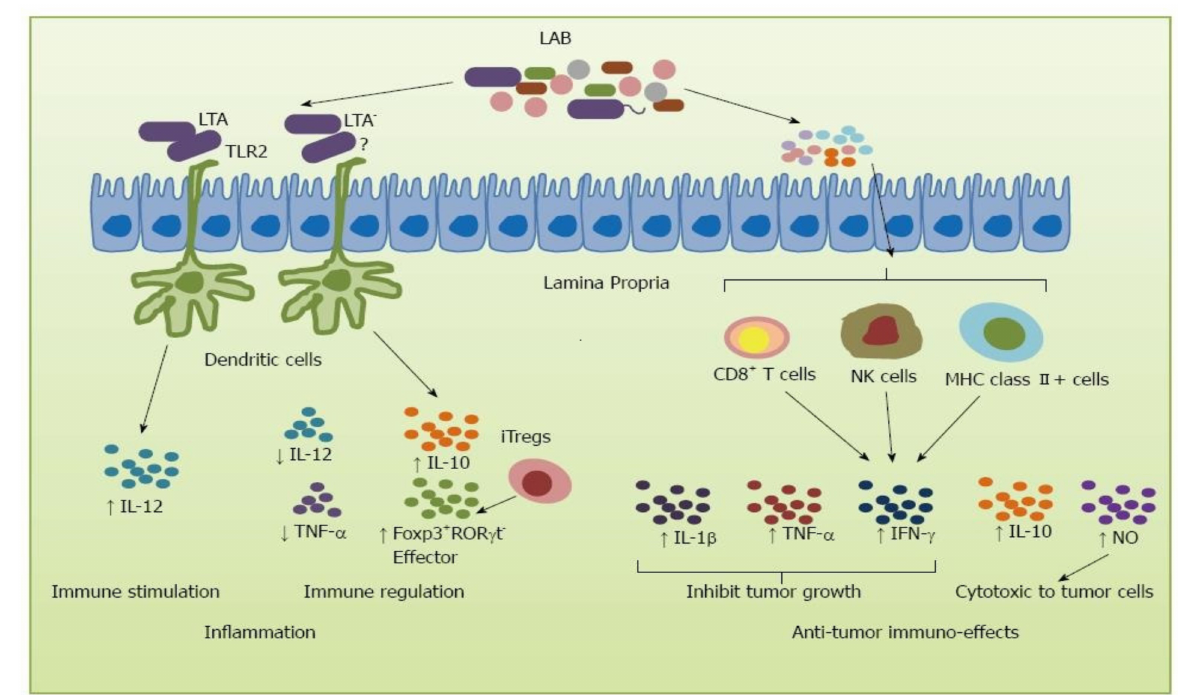
Figure 1. Immune responses induced by lactic acid bacteria. LAB can stimulate immune responses via two major pathways: inflammation and anticancer immune responses. The inflammation pathways include lipoteichoic acid (LTA) which stimulates T cells to release interleukin (IL)-10 and IL-12 and increase effectors Foxp3 + ROR γ t -Tregs. In the anticancer immune responses pathway, LAB stimulate the immune cells, such as T cells, dendritic cells (DC), natural killer (NK), and MHC class II cells to induce IL-10, and tumor necrosis factor (TNF)- α , interferon (IFN)- γ , and IL-1 β to inhibit tumor growth. Adopted from